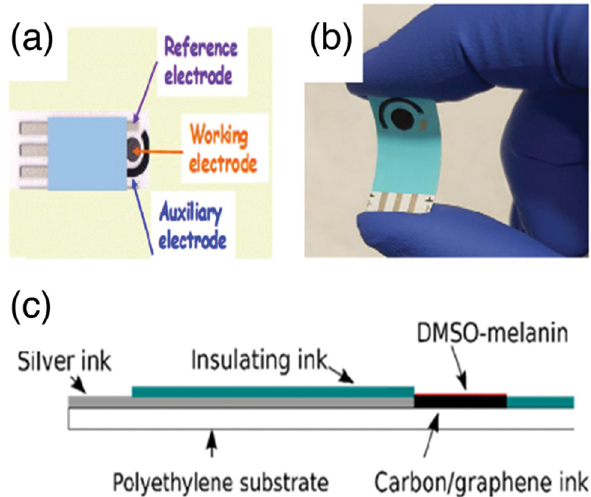
Figure 4: ( a ) Top view of electrode, ( b ) optical image of fl exible sensor and ( c ) electrode section of pH sensor based on graphene and pigment melanin ( PGM ) [ 112 ]